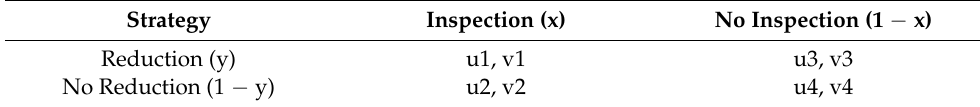
Table 2. Government and corporate payment